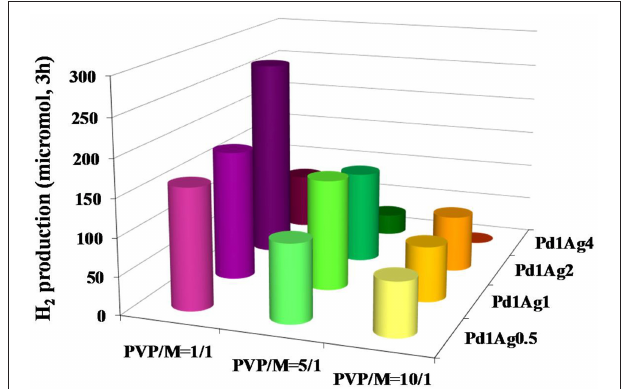
FIGURE 4 | H 2 generated after 3h of reaction over PdAg/C catalysts with a various composition of the nanoparticles. Adapted with permission from Navlani-García et al. (2016c). Copyright 2016 American Chemical